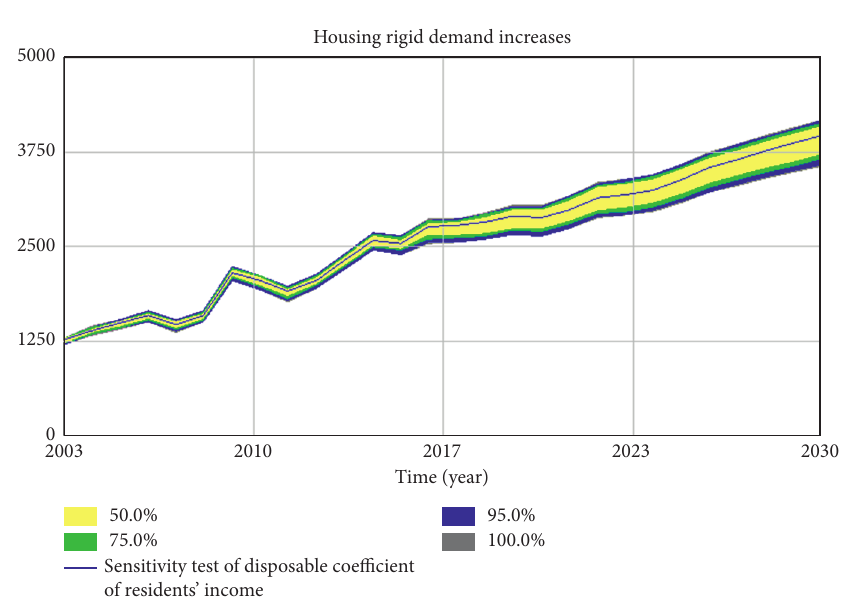
Figure 11: Sensibility test of the coefficient of disposable household income on rigid demand